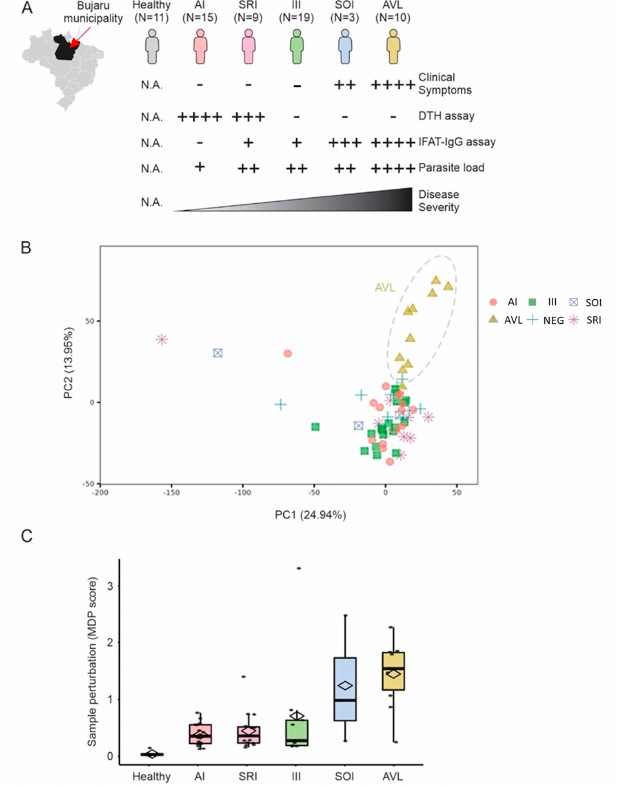
Figure 1. Blood transcriptome of individuals infected with L. ( L. ) chagasi . ( A ) Blood transcriptome from 67 individuals with AI, SRI, III, SOI, and SI (=AVL) profiles, or without infection (healthy control group), with L. ( L. ) chagasi from Bujaru municipality, Par á State, Brazilian Amazon, were used in our study. Individuals were grouped according to their clinical–immunological profiles. Clinical symp- toms evaluated were: daily fever, weakness, weight loss, hepatosplenomegaly, and hematological changes, such as anemia, leukopenia, and thrombocytopenia. Parasite load was assessed by real- time PCR targeting Leishmania kinetoplast minicircles. DTH = delayed-type hypersensitivity assay; IFAT-IgG = indirect fluorescence antibody test. Semi-quantitative scales (+) follow Silveira et al. [12]. ( B ) Principal component analysis using the entire expression data. Colors represent the groups in ( A ). Explained variance is shown for PC1 and PC2 in parenthesis. ( C ) Molecular degree of perturbation (MDP score) of samples. The y -axis shows the MDP score using the healthy subjects as a reference group. The scores for each group of infected individuals are shown in the